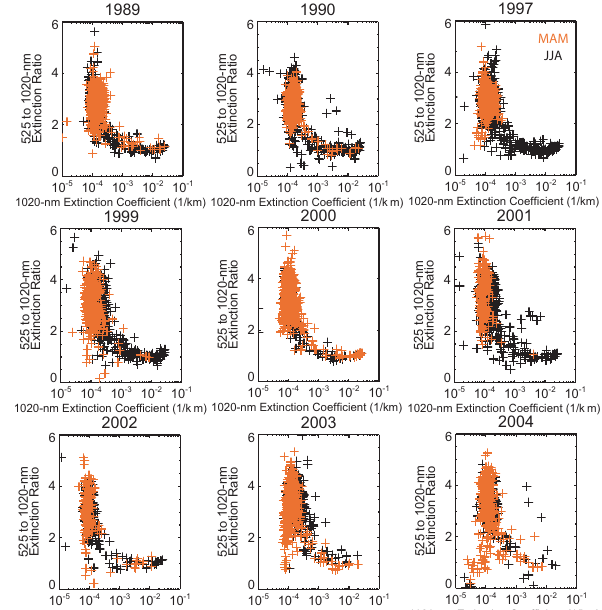
Fig. 11. Aerosol 1020nm extinction coefficient density as a func- tion of extinction coefficient for selected years between 1989 and 2005. Data from MAM is shown in red while data for JJA is shown in black.